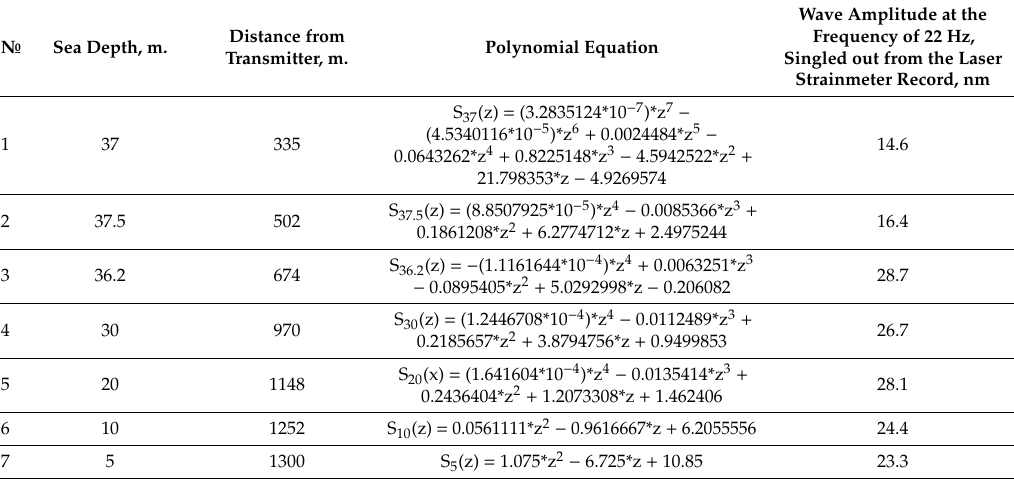
Table 1. Experimental data.